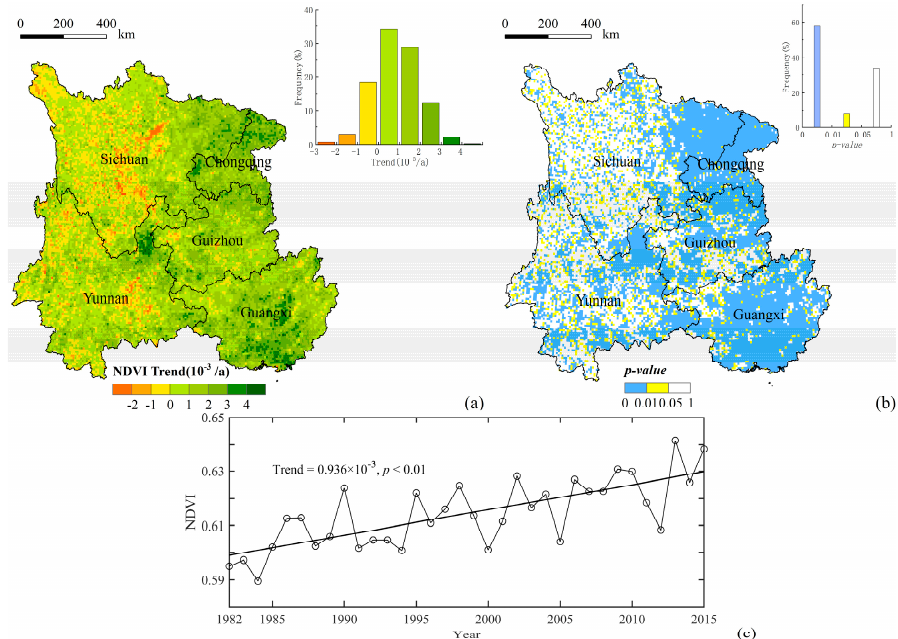
Figure 5. Spatial trend analysis of vegetation NDVI ( a ), the associated significant level ( b ) and linear regressions of NDVI ( c ) over Southwest China from 1982 to 2015.